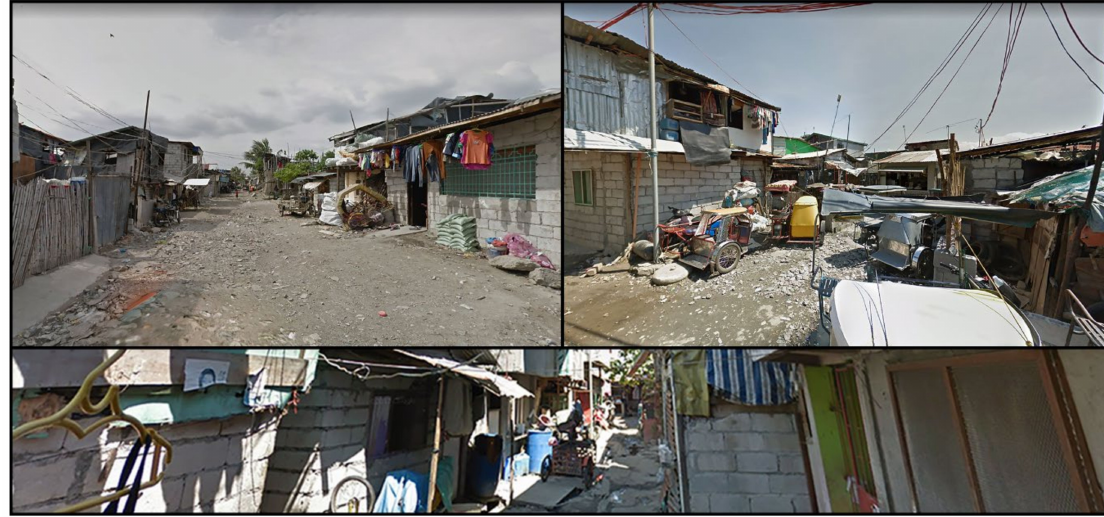
Figure 8. Squatters in different districts of BaSECo (Google Street View